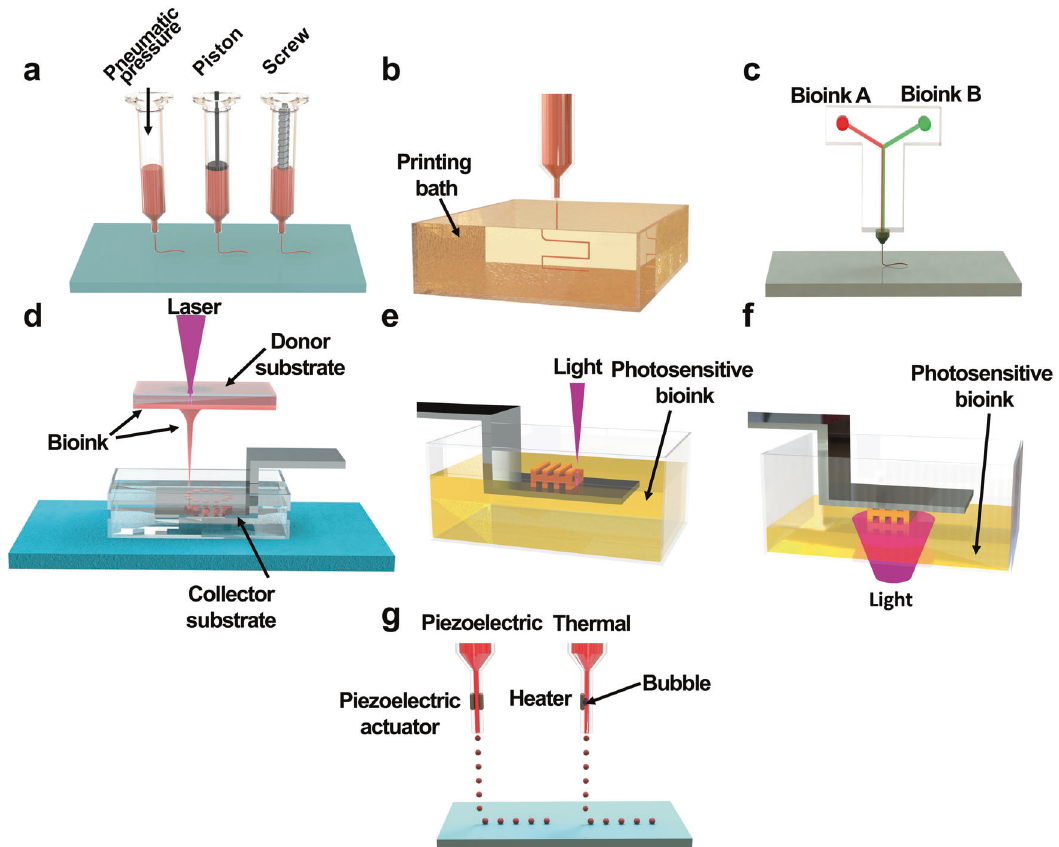
Fig. 2 Schematic diagrams of 3D bioprinting technologies. a Extrusion-based bioprinting, b FRESH-based bioprinting, c micro fl uidic chip- assisted bioprinting, d laser-induced forward transfer (LIFT), e stereolithography (STL), f digital light processing (DLP), g inkjet-based